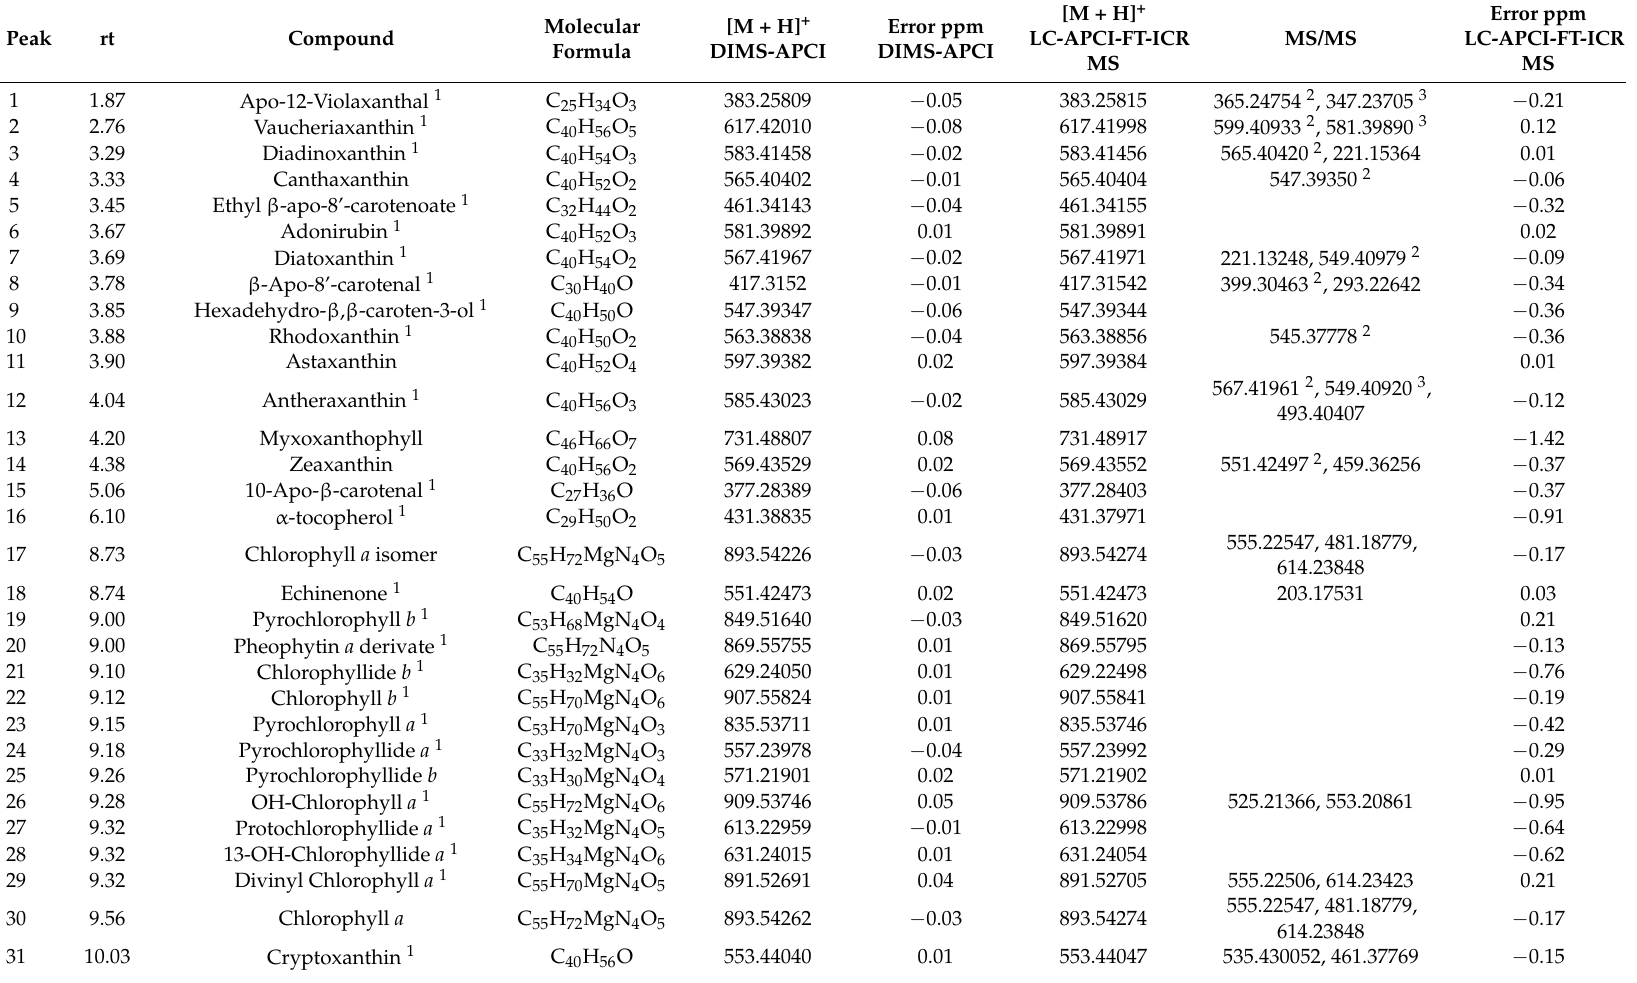
Table 1. DIMS-APCI and LC-APCI-FT-ICR MS identification of Spirulina